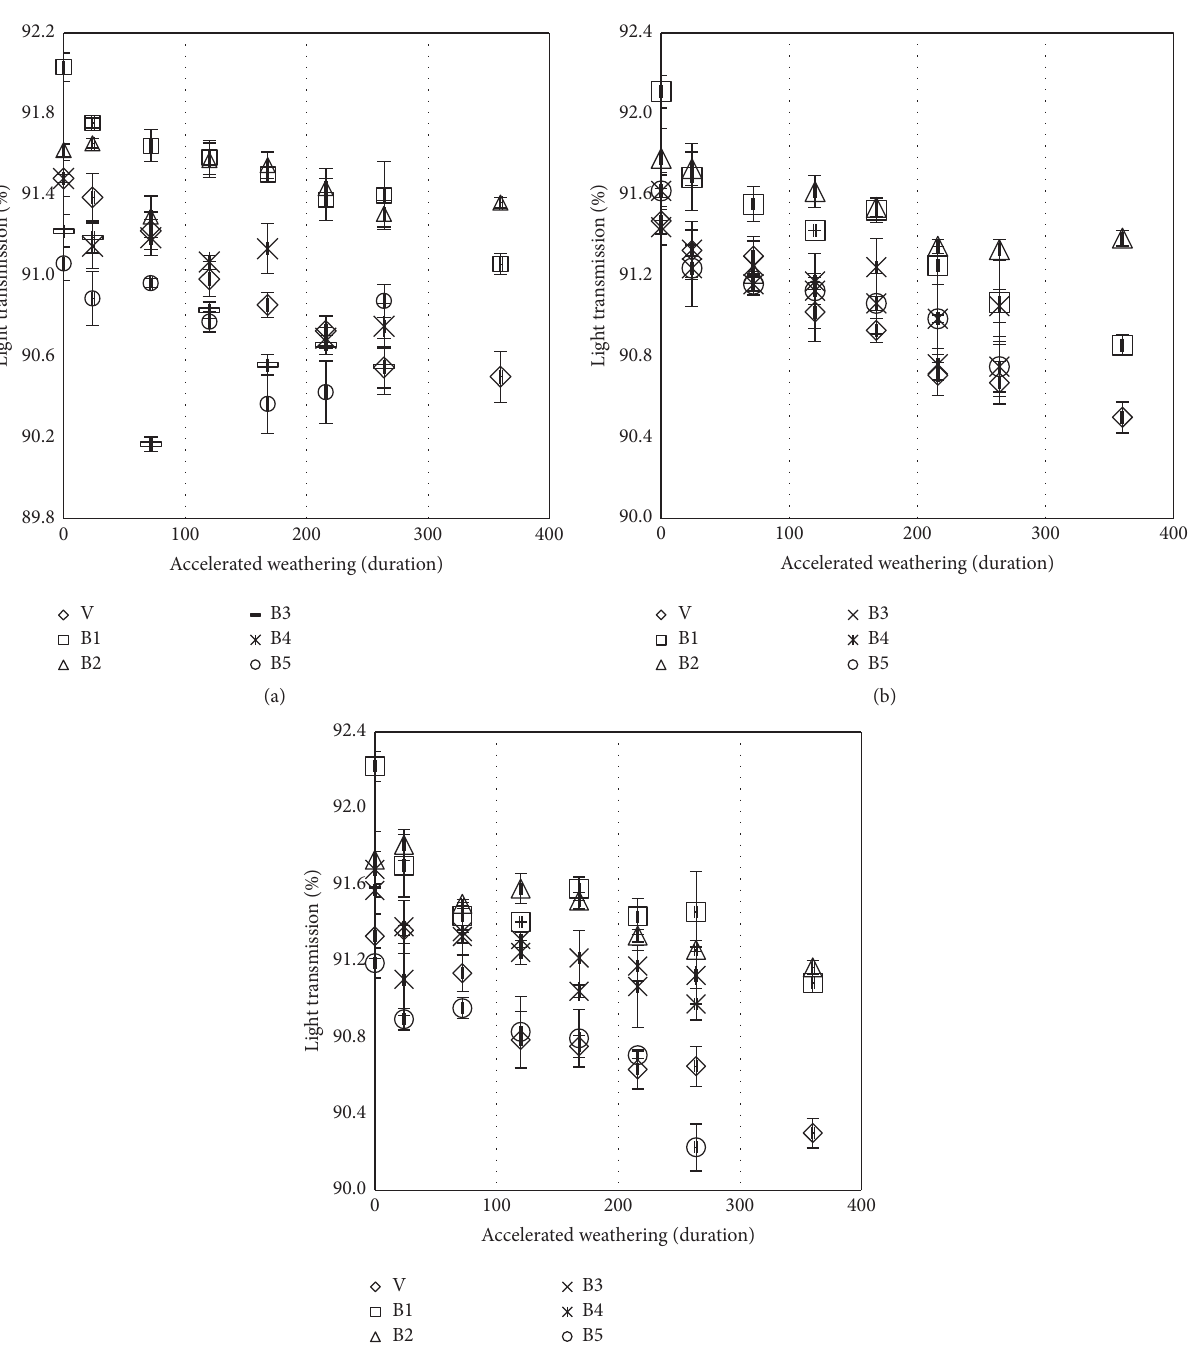
outdoor applications. V samples showed a very similar trend lack of dependency of haze (%) on the processing